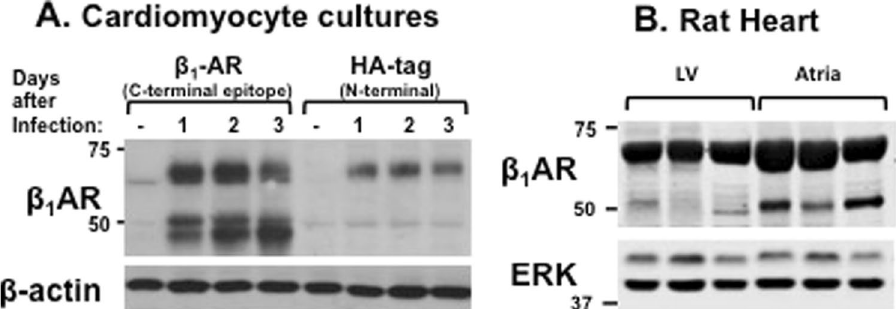
Figure 5. β 1 AR are detected as full-length and truncated species in cardiomyocytes. Panel A: Adenoviral- mediated gene delivery was used to overexpress N-terminally tagged β 1 ARs in neonatal rat cardiomyocyte cultures. Lysates were prepared at 1–3 days following infection and probed for β 1 ARs, with β -actin used as a protein loading control. Panel B: Lysates prepared from adult left ventricular (LV) or atrial tissues were probed for β 1 AR expression (with ERK protein serving as loading control, since the anti- β -actin antibody - which gives a very robust signal in various cell culture preparations - performed poorly in lysates prepared from intact rat hearts). A shorter exposure of the β 1 AR immunoblot is included as Fig.